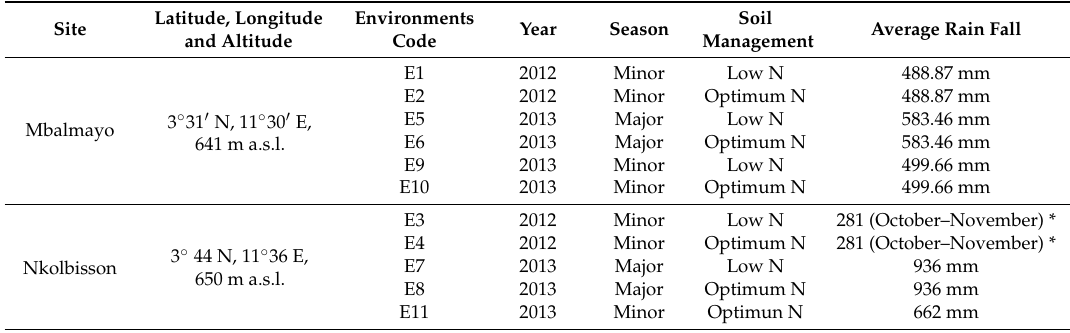
Table 2. Description of the eleven environments used to evaluate the 80 hybrids.